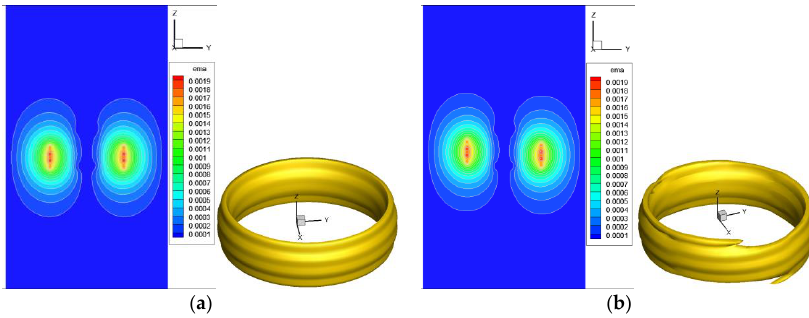
Figure 5. Contours of A 0 r for axisymmetric and spiral coils at I = 1250 A and F = 16 kHz. ( a ) axisymmetric coil; ( b ) spiral coil.